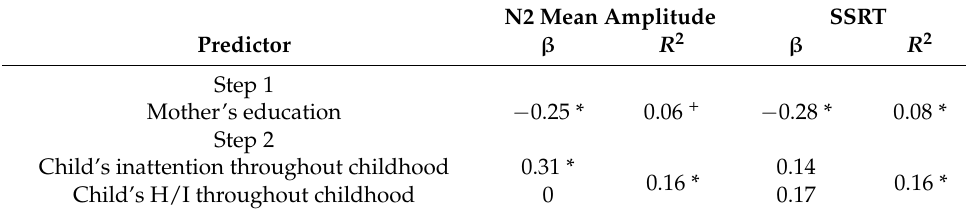
Table 4. Predicting Inhibitory Control in Adolescence from ADHD Symptoms Domains in Childhood.